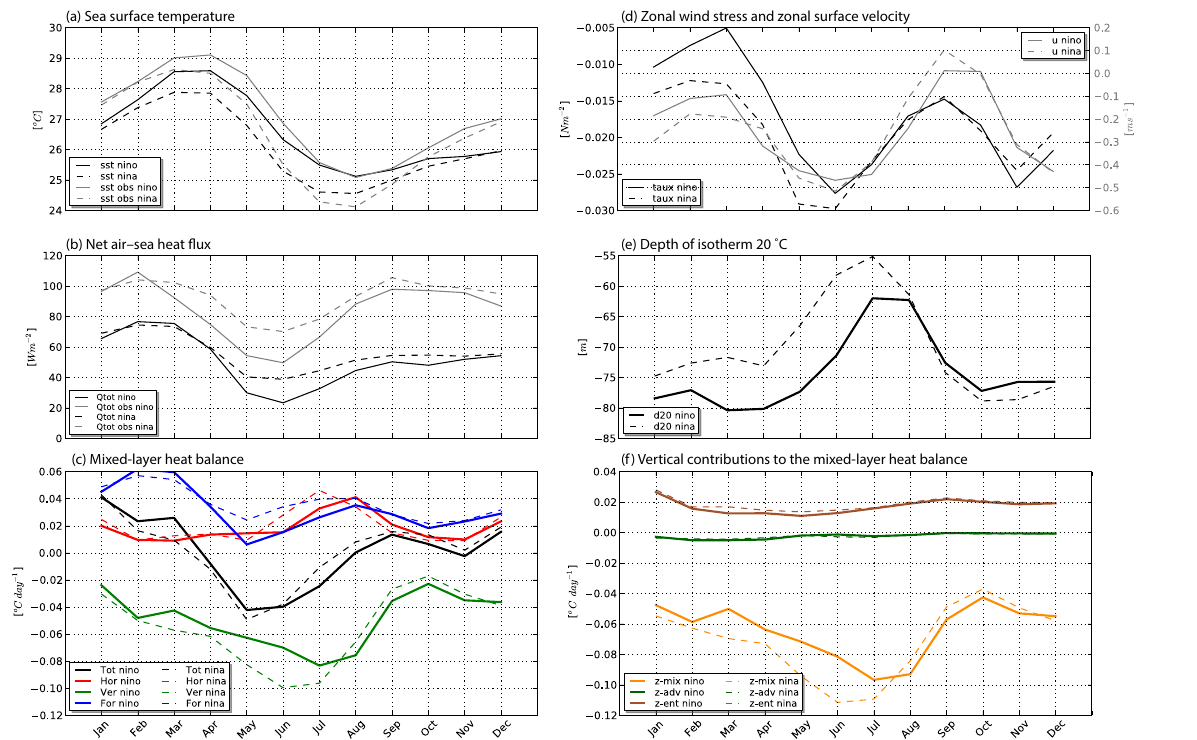
Figure 3. Composite seasonal evolution of variables from REF and observations averaged over Atl3 for Niño (continuous lines) and Niña years (dashed lines): (a) surface temperatures from model and TropFlux, (b) net air–sea heat flux from model and TropFlux; (c) mixed-layer heat budget contributions as defined in Eq. (1); (d) model zonal wind stress and zonal surface current; (e) depth of the isotherm 20 ◦ C; and (f) mixing, advection and entrainment contributions to the mixed-layer contribution VER. Niño and Niña years were selected using SST from TropFlux using the methodology described in Lübbecke and McPhaden